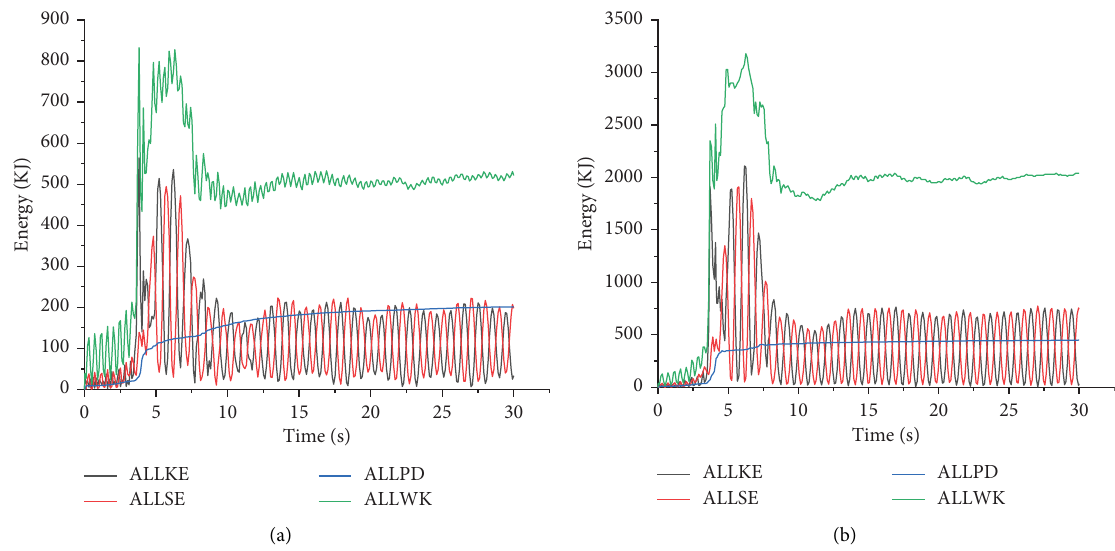
Figure 23: Variations of aqueduct structural energy under diferent conditions. (a) Condition 1. (b) Condition 3.